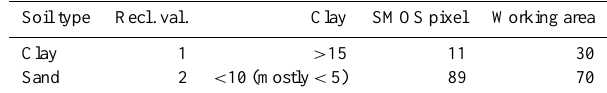
Table 3. Land cover information: land cover type, class numbers used in the sum-up to composite classes, and respective fractions [%] contained in the SMOS pixel and working area around Discrete Global Grid node